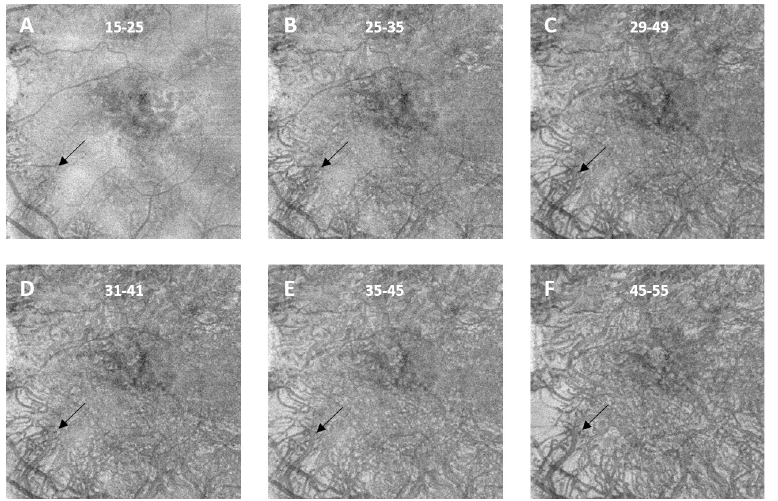
Fig 1. Structural en-face optical coherence tomography angiography images of an intermediate age-related macular degeneration eye, showing large choroidal vessels (LCV) within the choriocapillaris layer at different slab depths. The instrument´s automated retinal pigment epithelium fitted “RPE-fit” segmentation reference was used as a starting point from which the various offsets were applied. Manual correction was performed when necessary. LCV are first visible in the bottom left half of (A) and remain present throughout all other slab settings (black arrow) and become increasingly prominent with declining slab depth until they cover most of the image in (F). (A, B, E, F) show 10 μ m thick slabs with declining depth settings in 10 μ m increments. (C) shows the device´s default CC depth setting of 29–49 μ m, (D) shows the commonly used setting of a 10 μ m thick slab starting 31 μ m below the RPE-fit reference.